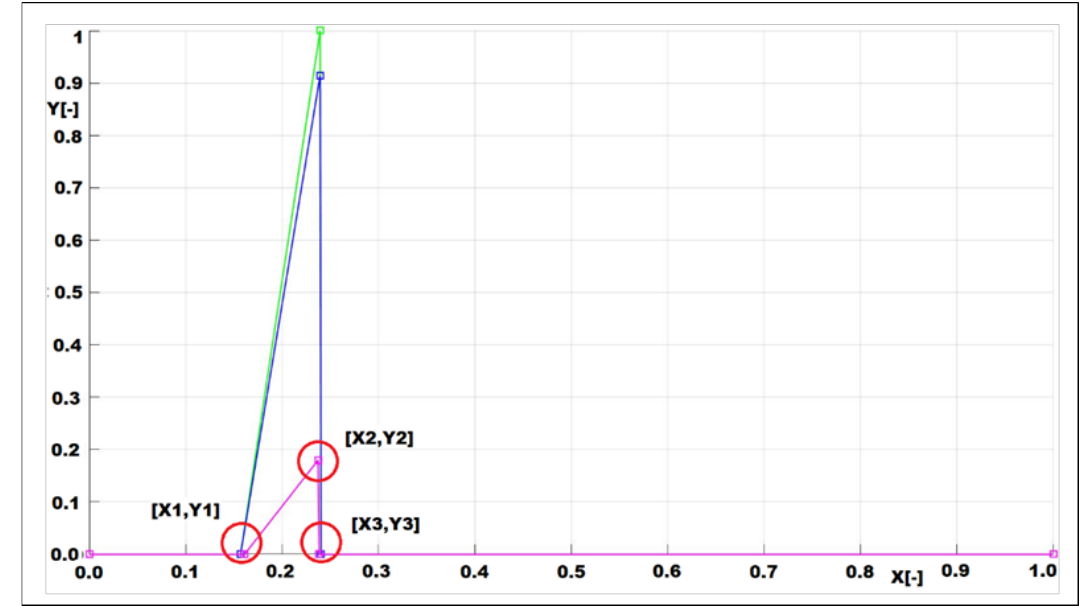
Figure 10. Example of the opacity (pink color) LUT with marked points that are used for computation Figure 10 . Example of the opacity (pink color) LUT with marked points that are used for of the centroid. Such figure exists for every included image (mouse_1_liver_ethanol_100_%_day_16). computation centroid. Such figure exists for every included image Table 1. p -values of the Lilliefors test of normality. Table 1. p -values of the Lilliefors test of normality.